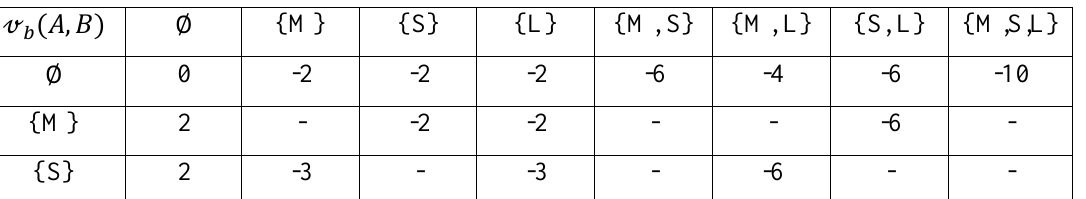
Table 2: Bi-capacity